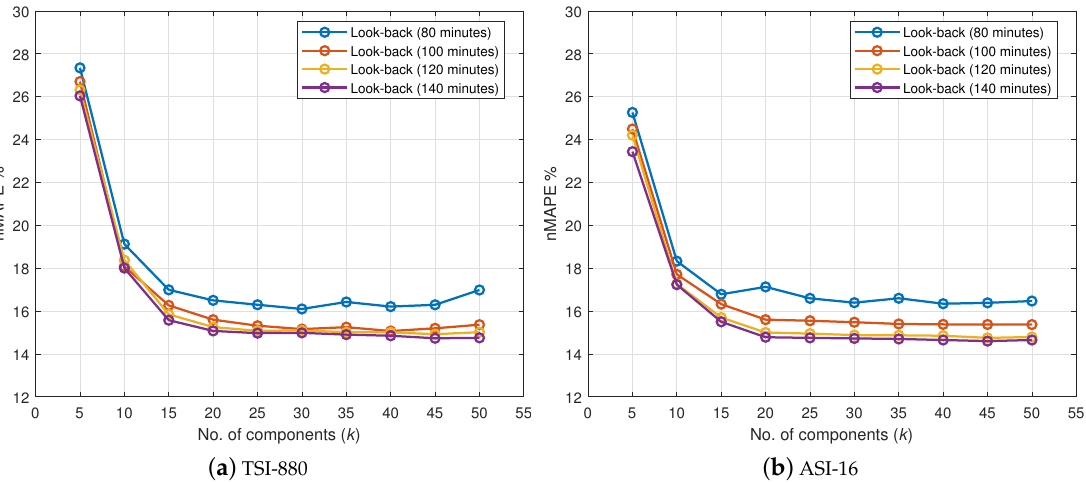
Figure 3. Normalized mean absolute percentage error (nMAPE) vs. k value for different look-back intervals.